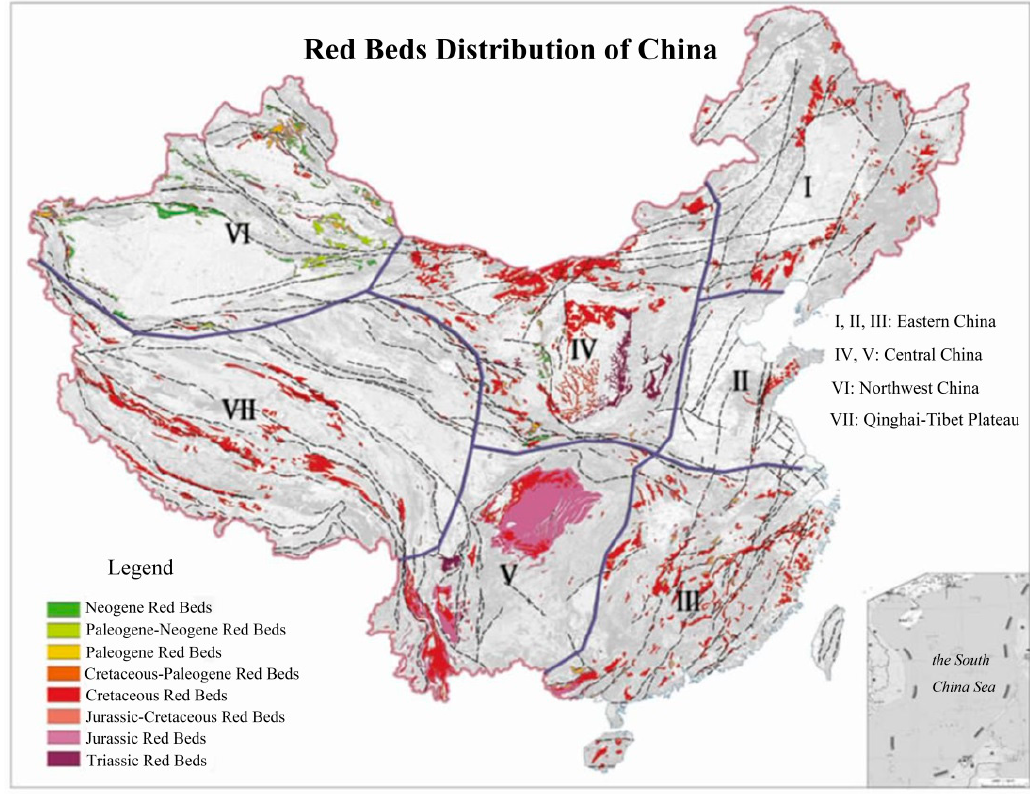
Figure 1. Distribution of red beds in China [1].